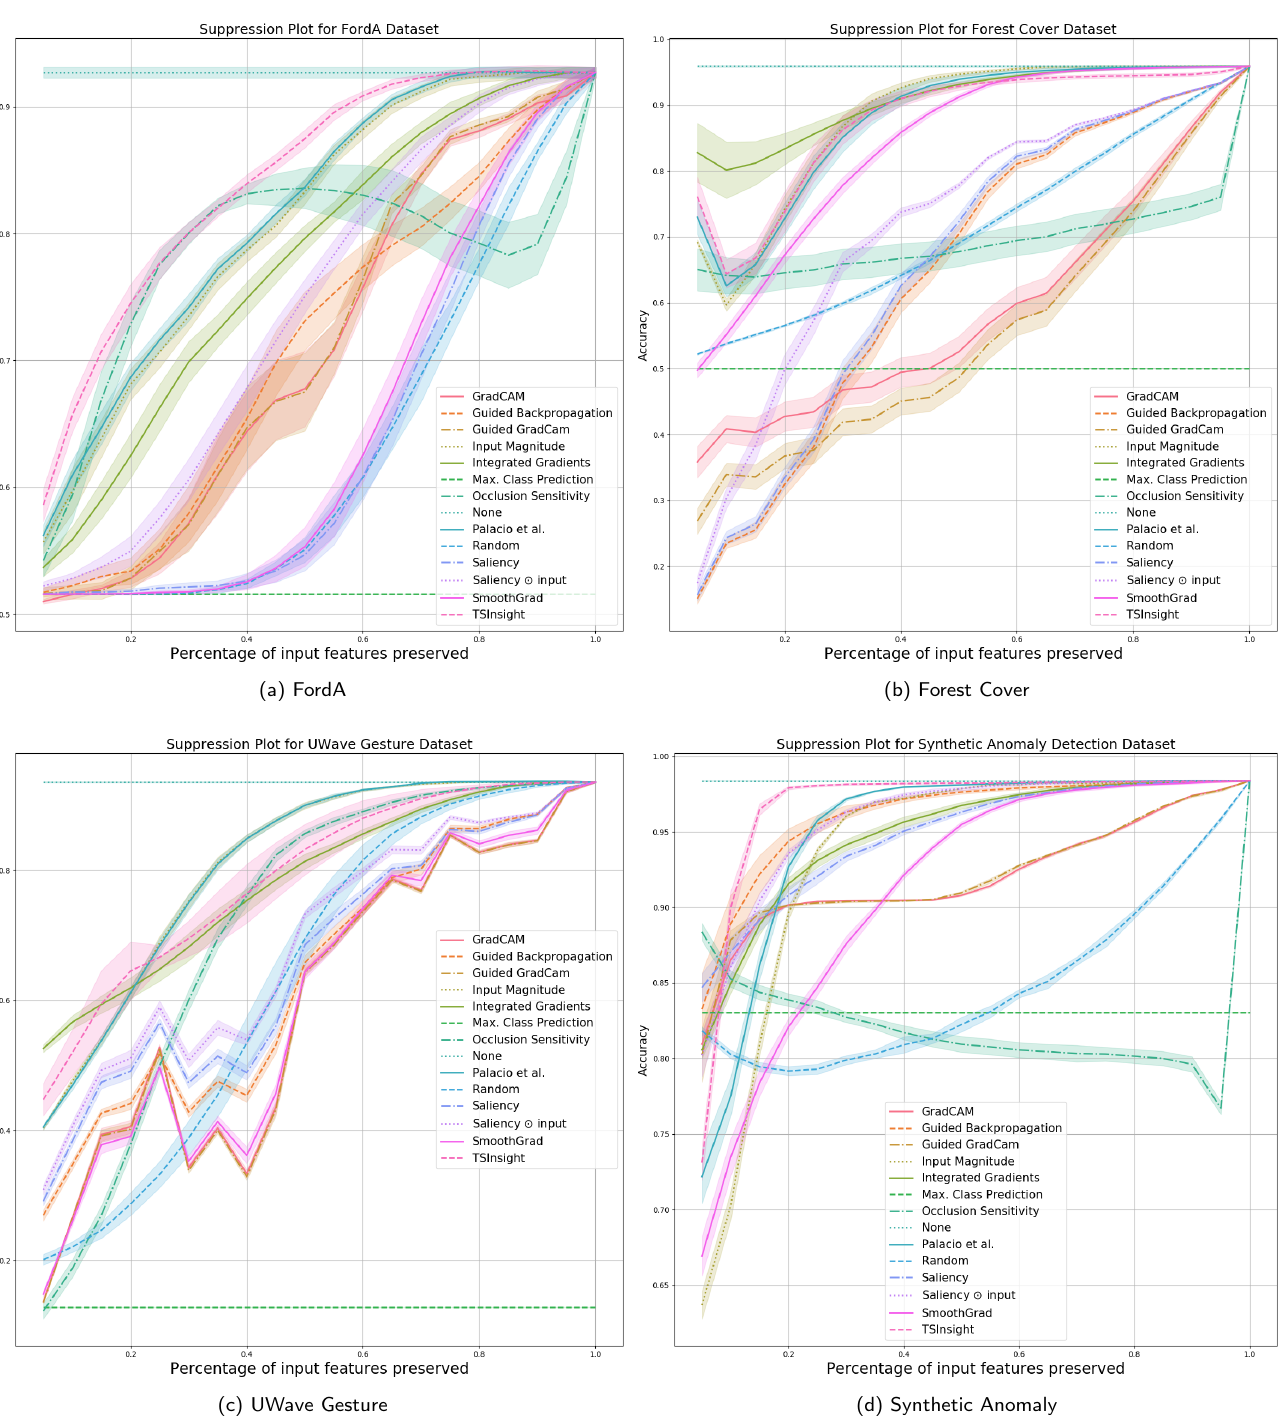
Figure 4. Suppression results (2/2) against a large number of baseline methods computed using 5 random runs (best viewed